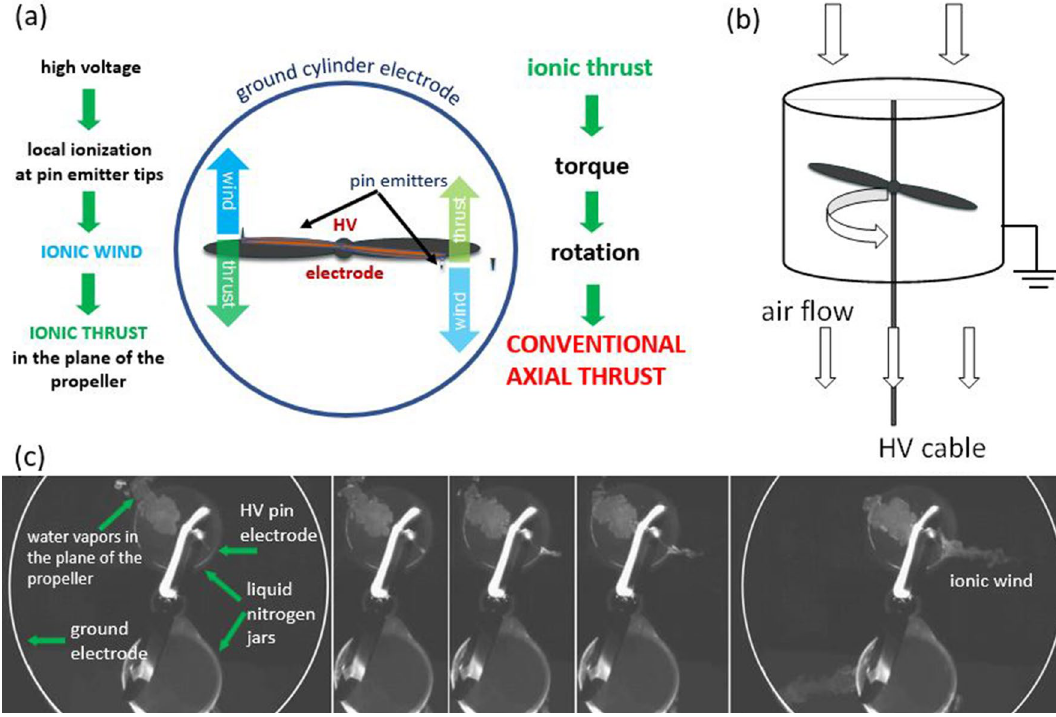
Figure 1. ( a ) Schematics of the mechanism of thrust in an ionic propeller-cylindrical counter electrode RIE (top view). ( b ) Side view of the RIE with cylindrical counter electrode and ionically induced air flow. ( c ) From left to right: 50ms image sequence of the ionic wind initiation in a RIE with cylindrical collector. A laser sheet was projected within the plane of the propeller rotation to visualize condensed water vapors induced by a